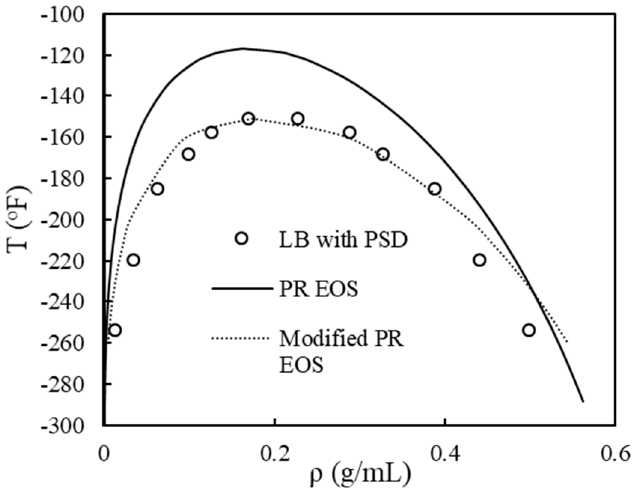
Figure 8. Comparison of coexistence curves of methane using PR EOS, modified EOS, and LB simulation.